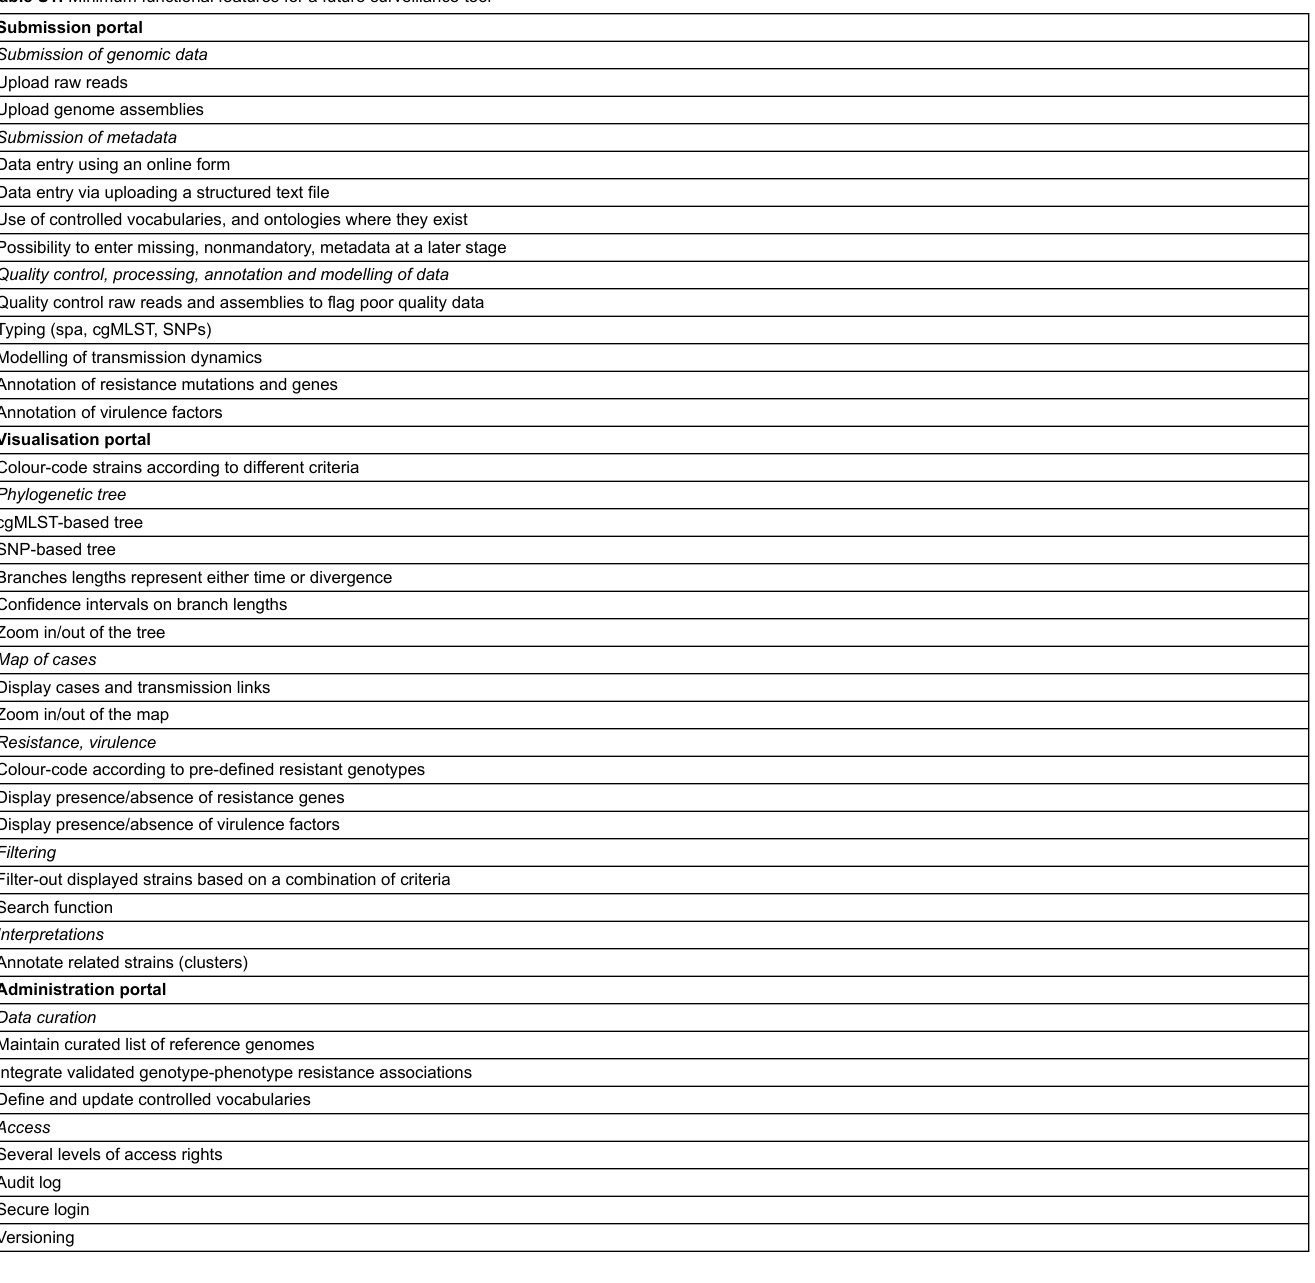
Table S1: Minimum functional features for a future surveillance